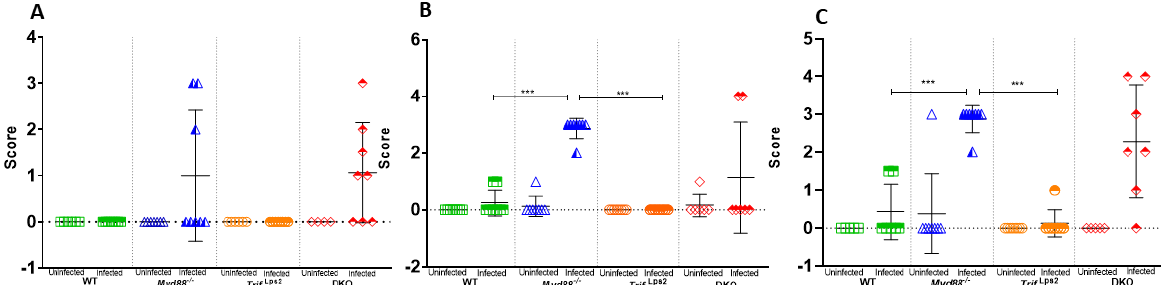
Figure 5. Histopathological scoring for mucous metaplasia. Following infection with H. felis for 1 month ( A ), 3 months ( B ) and 6 months ( C ), H&E-stained stomach sections from each mouse (WT and Myd88 − / − , Trif Lps2 and DKO) were evaluated for indications of pathology. Mucous metaplasia was scored by a blinded comparative pathologist according to the criteria described in Materials and Methods. A p value of 0.05 was considered statistically significant. ( A ) 1month post infection, n =14 for WT, n =15 for Myd88 − / − , n = 14 for Trif Lps2 , and n = 12 for DKO mice; ( B ) 3 months post infection, n = 16 for WT, n = 16 for Myd88 − / − , n = 16 for Trif Lps2 , n = 13 for DKO mice; ( C ) 6 months post infection, n =12 for WT, n = 16 for Myd88 − / − , n = 16 for Trif Lps2 , n = 12 for DKO mice. Statistical significance was determined by Mann-Whitney test, *** p < 0.005).